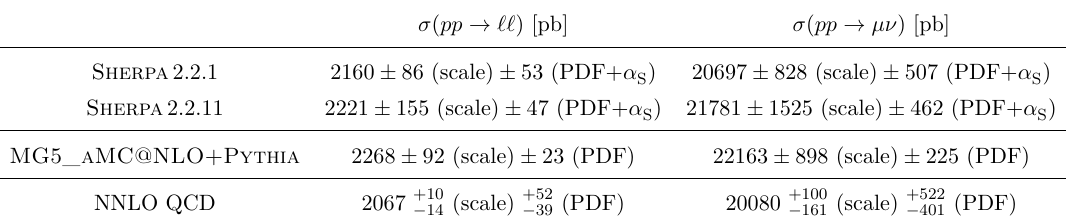
Table 2 . Event generator predicted cross-sections for each of the MC configurations. The reference NNLO QCD cross-section is calculated with FEWZ [53] using the MSTW2008nnlo PDF set.